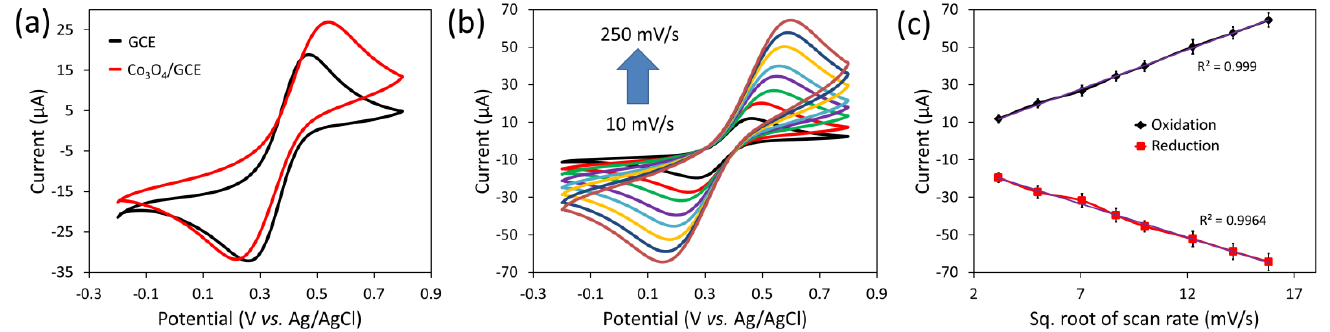
Figure 3. EIS spectra of bare GCE and cobalt oxide/GCE electrodes recorded in the redox probe solution of [Fe(CN) 6 ] 3−/4− with KCl (0.1 M) “as supporting electrolyte”. ( a ) Nyquist plots of bare GCE (black line) and cobalt oxide/GCE (red line) electrodes and their respective Bode plots ( b and c ). Inset a shows the Randle circuit.